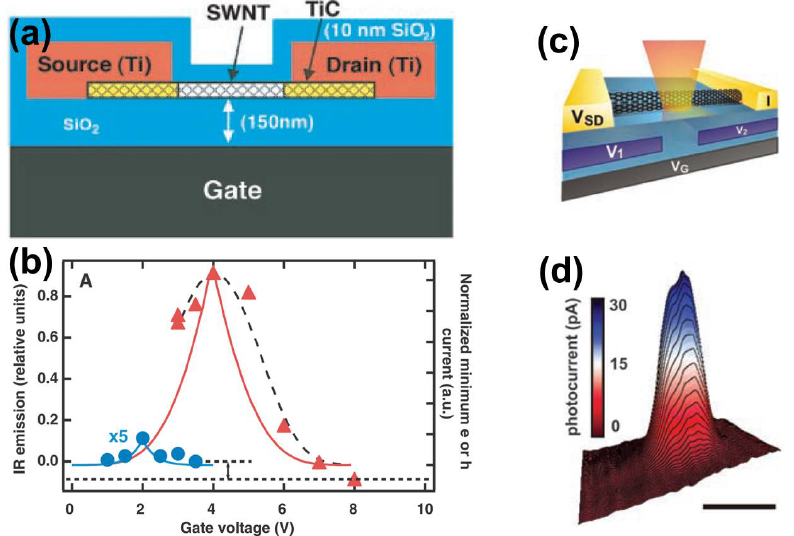
Figure 2. ( a ) Schematic drawing of an ambipolar semiconducting single-walled carbon nanotube (SWNT) device and ( b ) infrared emission intensity during repeated sweeps of the drain potential as a function of gate voltage. Reproduced with permission form [12], Copyright The American Association for the Advancement of Science, 2003. ( c ) Schematic of a typical split-gate device for photocurrent generation under focused optical illumination and ( d ) a spatially-resolved photocurrent two-dimensional map with a continuous laser excitation emitting at the wavelength 532 nm and optical power density 25 W/cm 2 for a device of diameter d = 1.8 nm. Scale bar, 1 mm. Reproduced with permission from [15], Copyright The American Association for the Advancement of Science,